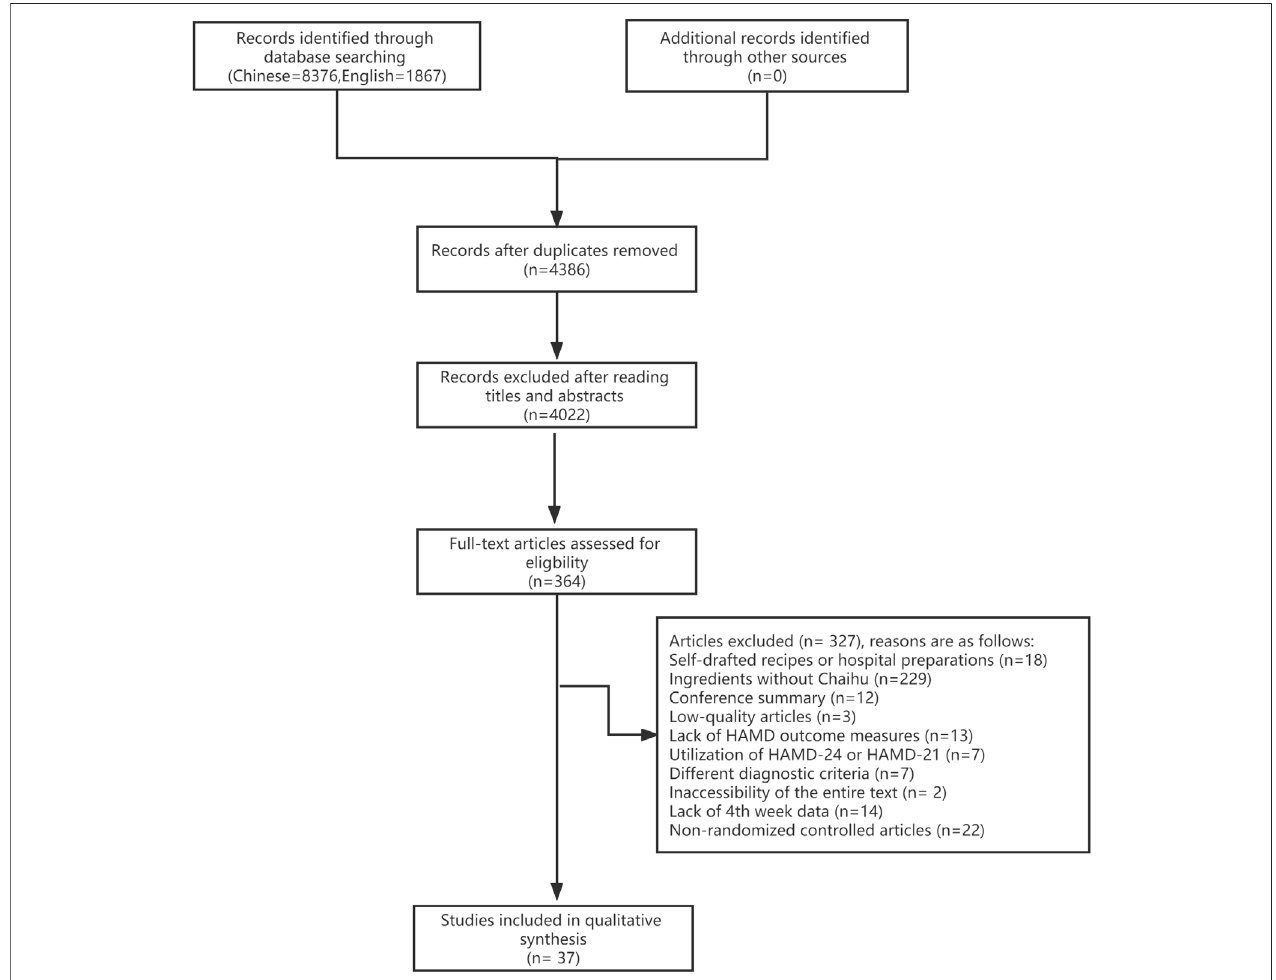
FIGURE 1 | Literature screening